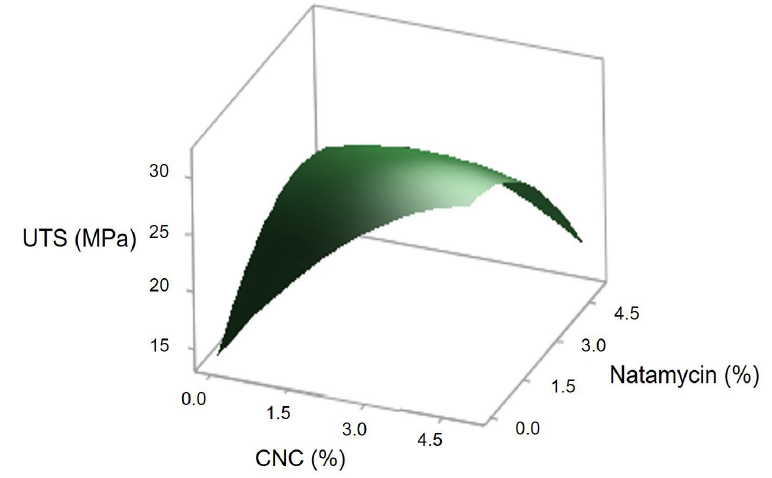
Figure 3. Three-dimensional response surface plot for ultimate tensile strength (UTS) as a function of cellulose nanocrystals (CNC, X 1 ) and natamycin (X 2 ) concentrations.